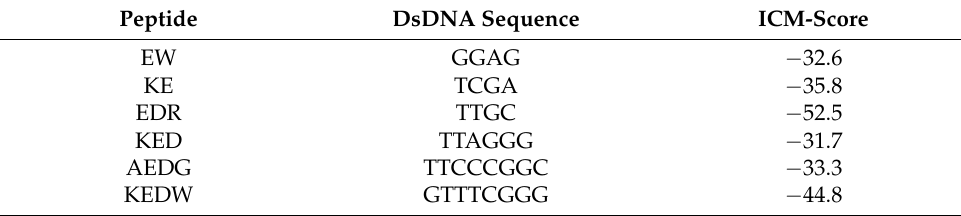
Table 1. Assessment of binding of short peptides to dsDNA in the classical B-form.